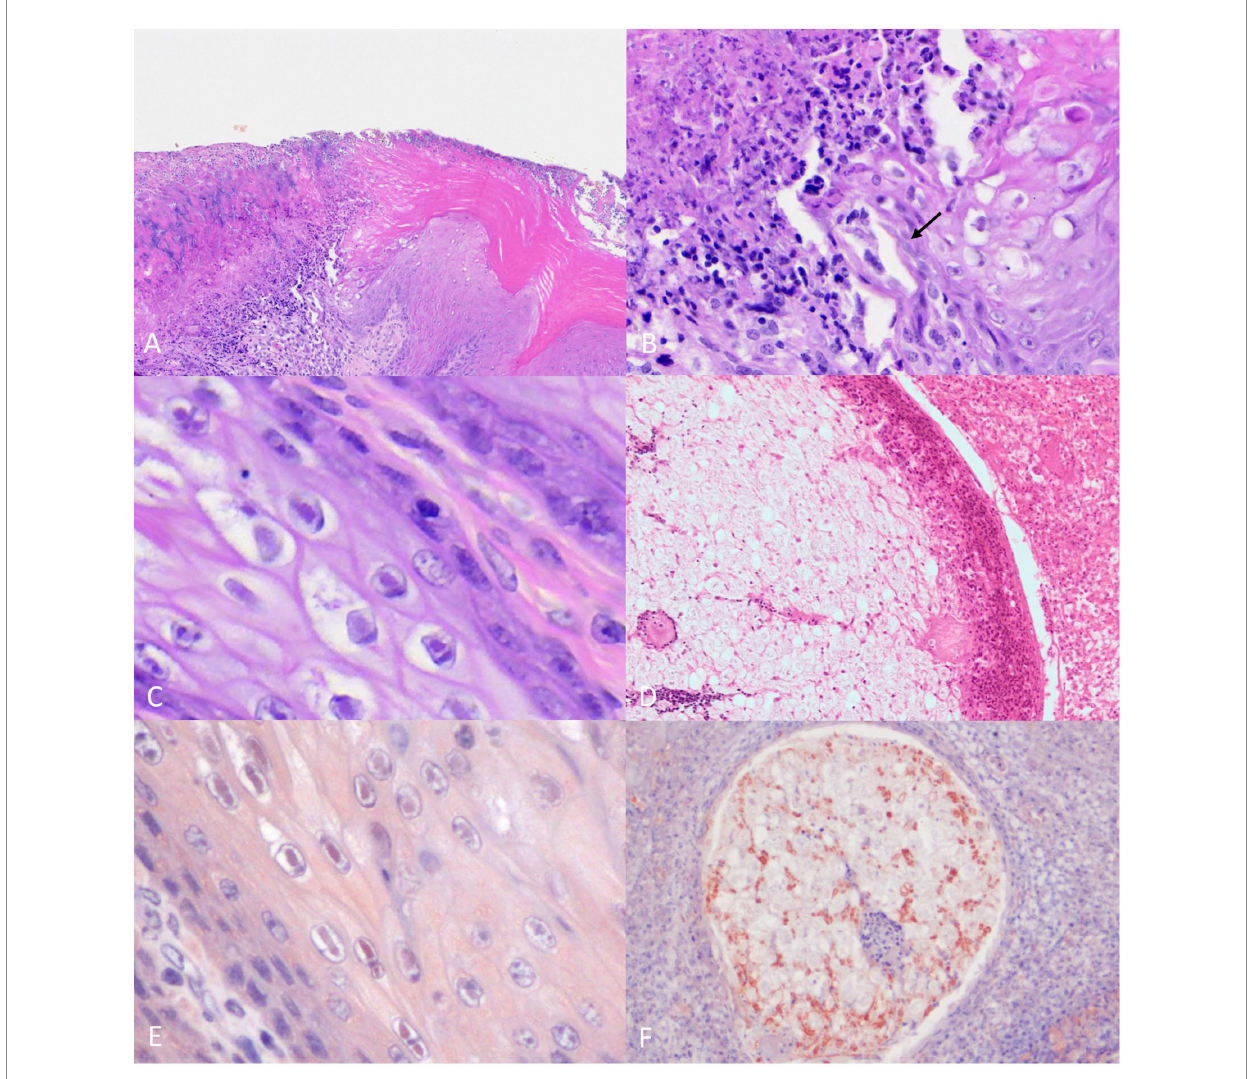
FIGURE 2 Histopathological findings of the common buzzard. (A) Necrosis of the oral mucosa covered by abundant fibrinoheterophilic exudate. 10× H&E stain. (B) Higher magnification of the same area of panel A . Detail of the mucosal necrosis and presence of intralesional mycotic hyphae (arrow). 40× H&E stain. (C) Tongue epithelium showing eosinophilic intranuclear viral inclusion bodies. 60x H&E stain. (D) Optic branch of the trigeminal nerve with neuritis and perineuritis (10×). (E) Esophageal epithelium showing intranuclear positive immunolabeling for HSV. 60× IHC. (F) Trigeminal nerve branch with intra-axonal immunolabeling for HSV. 20×